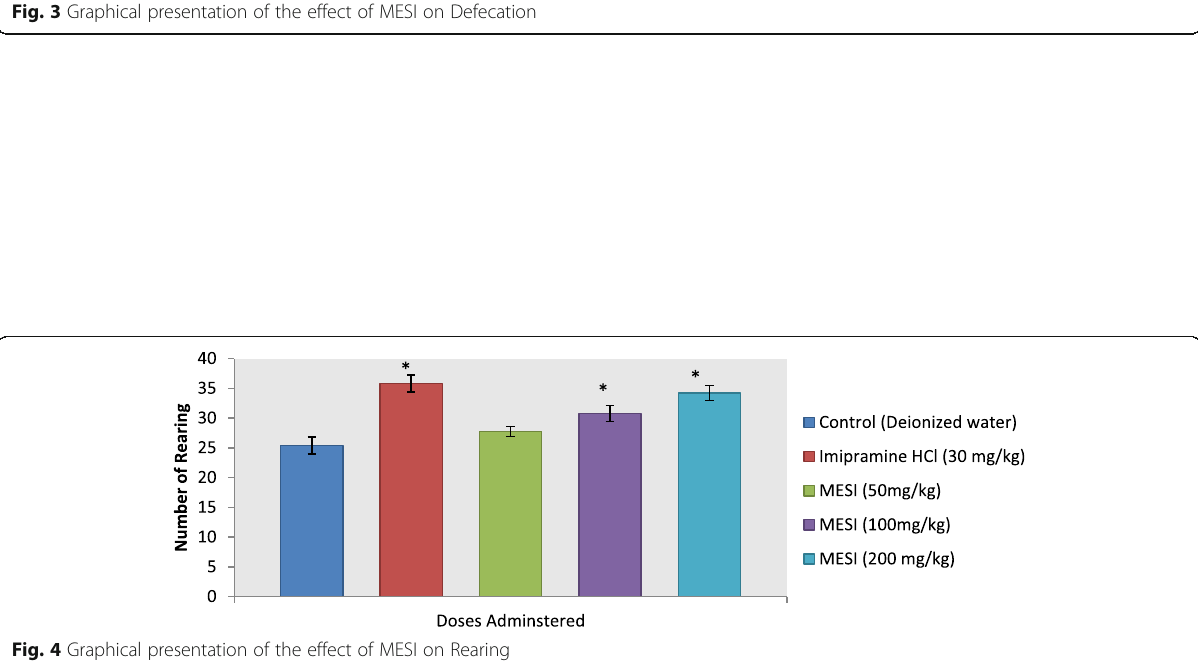
Fig. 4 Graphical presentation of the effect of MESI on Rearing